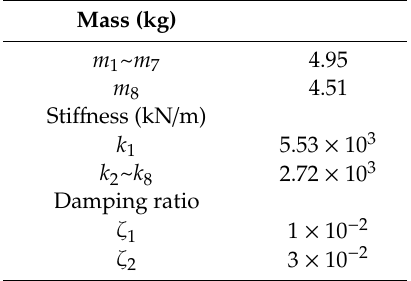
Table 1. Structure properties of the 8-DOF system.